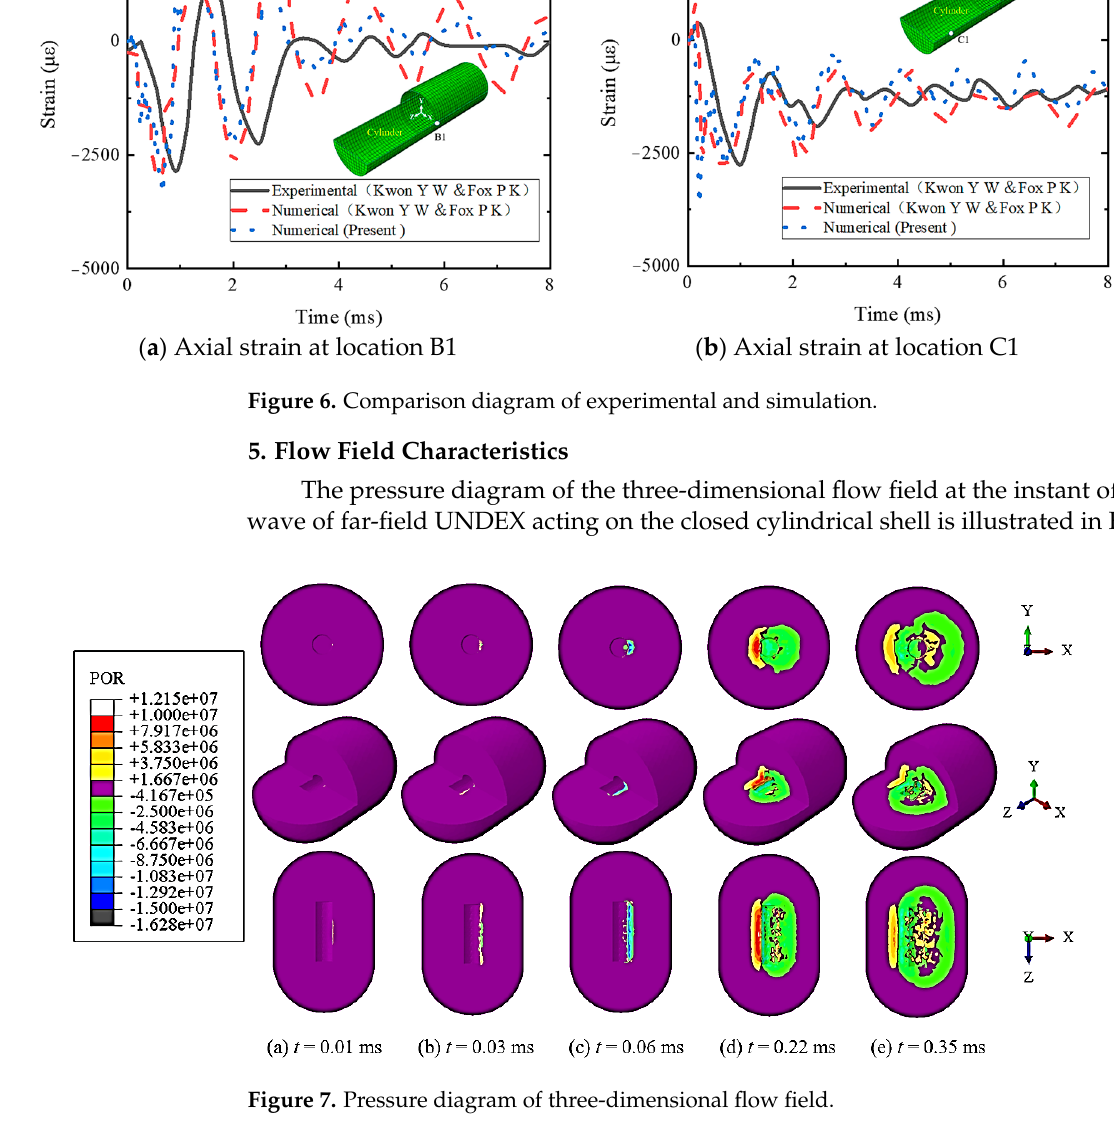
Figure 5. Shock pulse.